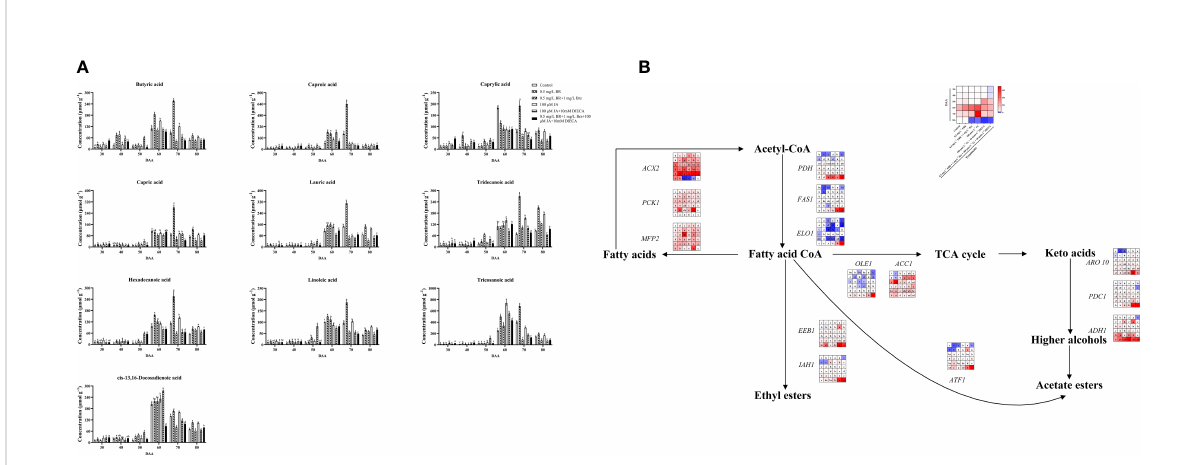
FIGURE 4 Effect of exogenous EBR, JA and their signaling inhibitors on fatty acids enrichment. (A) Effect of exogenous EBR, JA and their signaling inhibitors on diverse fatty acids contents in different treatment groups (Control, 0.5 mg L -1 EBR, 100 m mol L -1 JA, 0.5 mg L -1 EBR + 1 mg L -1